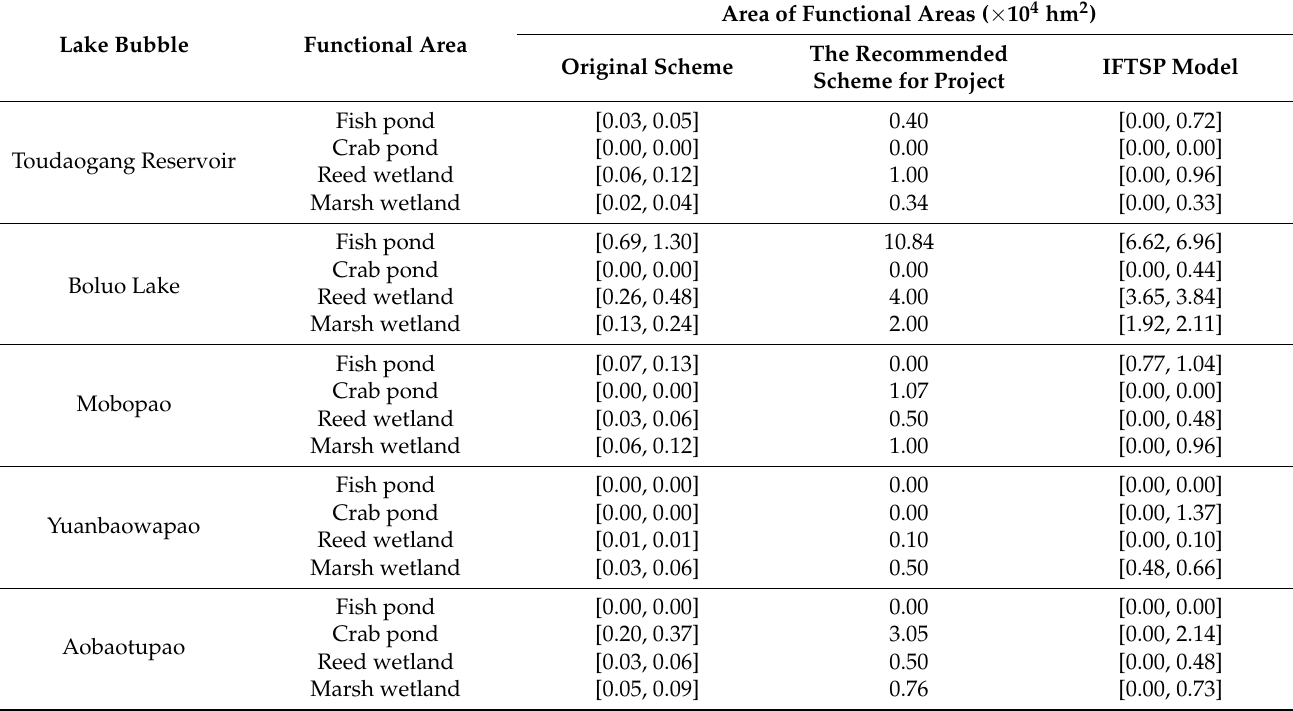
Table 5. Functional area of each land type in different study areas within Boluo